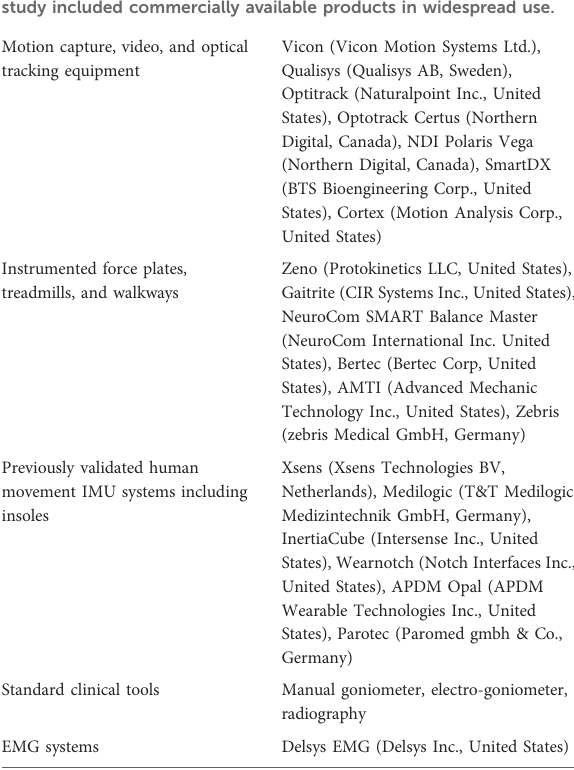
TABLE 1 De fi nition of gold standard for the purposes of the current study included commercially available products in widespread use.